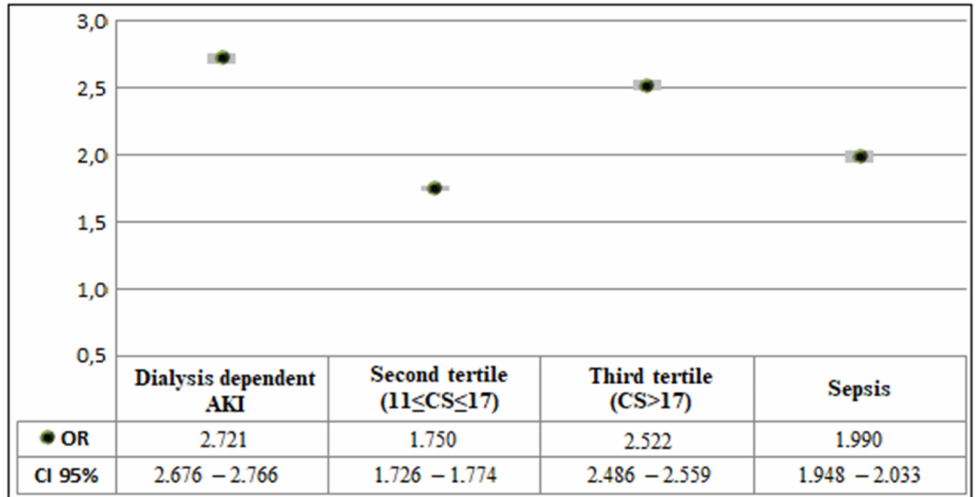
Figure 3. Multivariate analysis results relating the association between in-hospital mortality, comorbidity, and dialysis treatment in individuals with acute kidney injury. CS: Comorbidity Score (in all cases p < 0.001; Hosmer and Lemeshow test p <